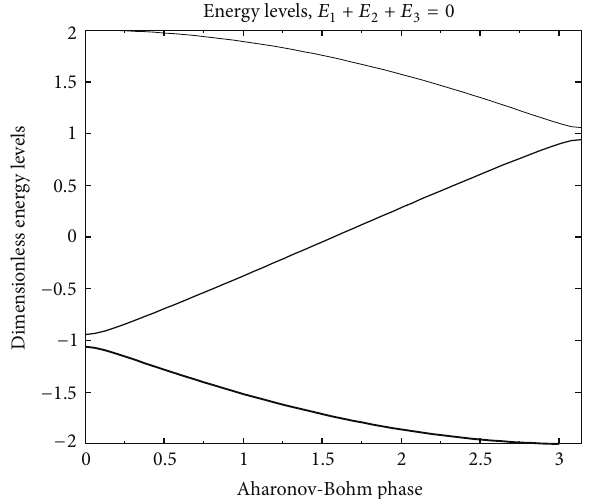
Figure 5: Variation within the magnetic Aharonov-Bohm phase 𝜙 of the energy spectrum (units 𝐷 0 = 1 ) for a choice of 𝐸 1 ,𝐸 2 , and 𝐸 3 with 𝐷/𝐷 0 = 0.01 . In this work, we are interested in the 𝜙 = 0 limit of this spectrum, which can be treated, at low- 𝑇 , as that of an effective 2LS.